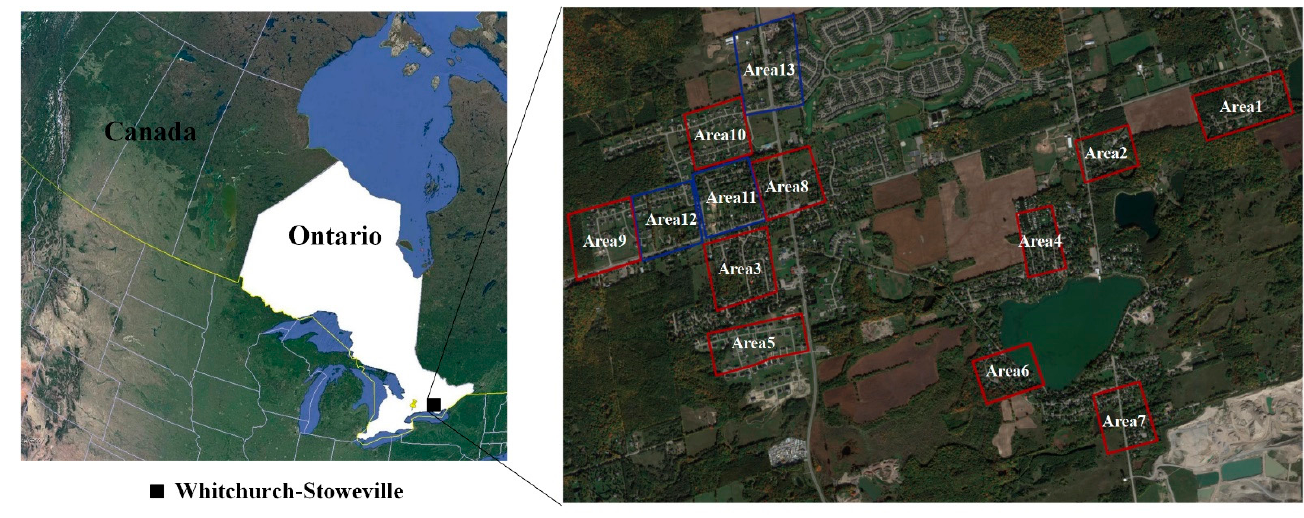
Figure 1. Study areas.